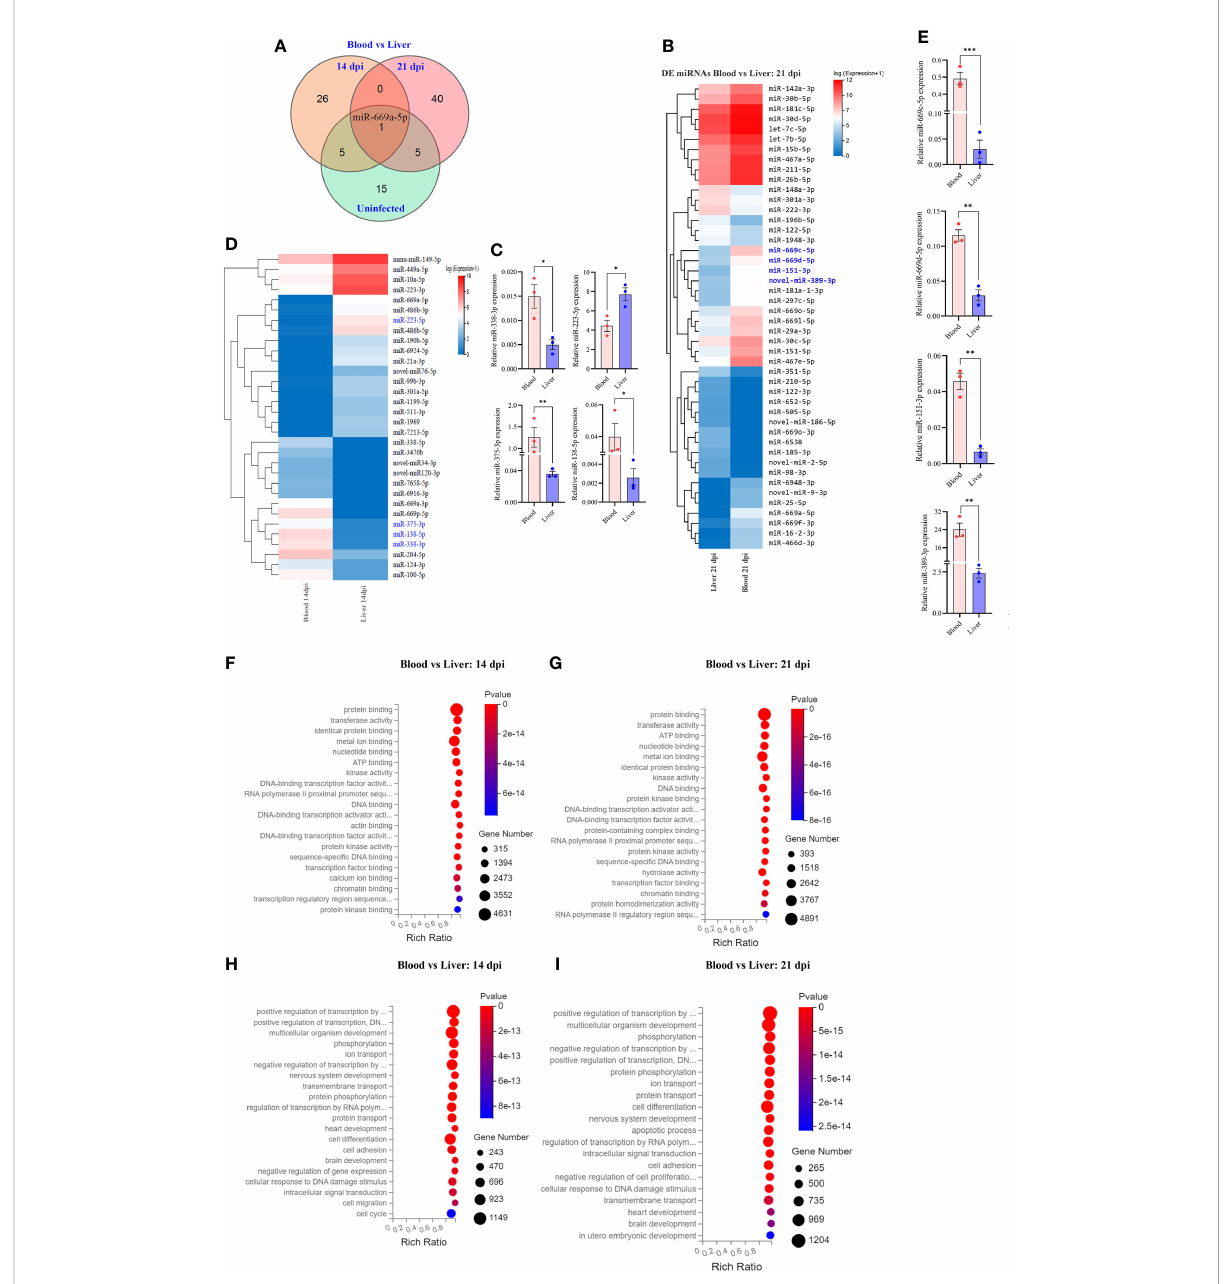
FIGURE 4 Comparative analyses of T cell miRNA expressions between blood and liver at 14 dpi and 21 dpi. (A) Comparison of differentially expressed miRNAs between blood and liver showing co-detected and speci fi c miRNAs at 14 dpi, 21 dpi and uninfected control; (B) Heatmap showing differentially expressed T cell miRNAs between blood and liver at 14 dpi (miRNAs highlighted in blue color are validated by RT-qPCR); (C) RT- qPCR validation of the expressions of selected miRNAs between blood and liver at 14 dpi. Data illustrate representative results and show the mean and standard error mean from an experiment carried out in triplicate. Statistical analysis was performed comparing blood and liver using Student ’ s T-test and * denotes P ≤ 0.05, ** denotes P ≤ 0.01. (D) Heatmap showing differentially expressed T cell miRNAs between blood vs liver at 21 dpi (miRNAs highlighted in blue color are validated by RT-qPCR); (E) Validation of the expressions of selected miRNAs from blood vs liver at 21 dpi by RT-qPCR; For RT-qPCR, data illustrate representative results and show the mean and standard error mean from an experiment carried out in triplicate. Statistical analysis was performed between S. japonicum infected mice blood and liver isolated T cells at 14 dpi and 21 dpi using Students T test and ** denotes P ≤ 0.01, *** denotes P ≤ 0.001; (F, G) GO analysis of molecular functions of targets for differentially expressed T cell miRNAs between blood and liver at 14 dpi (F) or at 21 dpi (G) ; (H, I) GO analysis of biological processes of targets for differentially expressed T cell miRNAs between blood and liver at 14 dpi (H) or at 21 dpi (I)